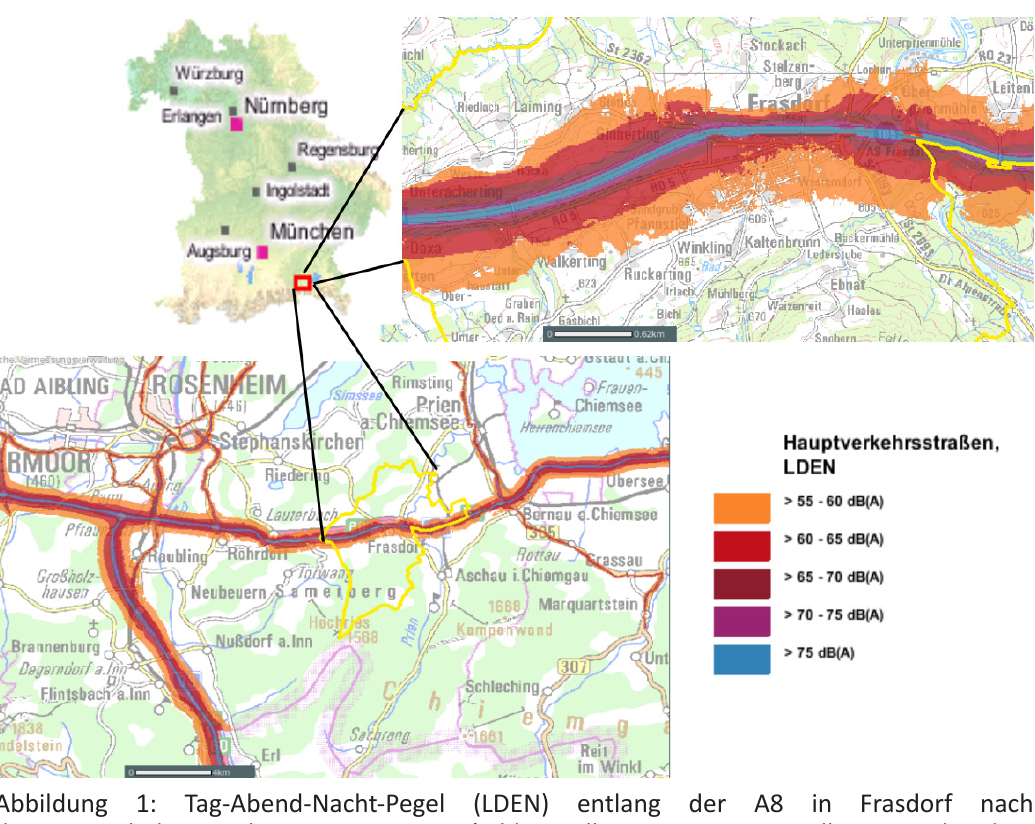
Figure 1: Day-evening-night traffic noise levels (LDEN) along the A8 in Frasdorf according to the noise pollution cadastre of the state of Bavaria (figure source: own representation based on the noise protection cadastre, Bayerisches Landesamt für Umwelt